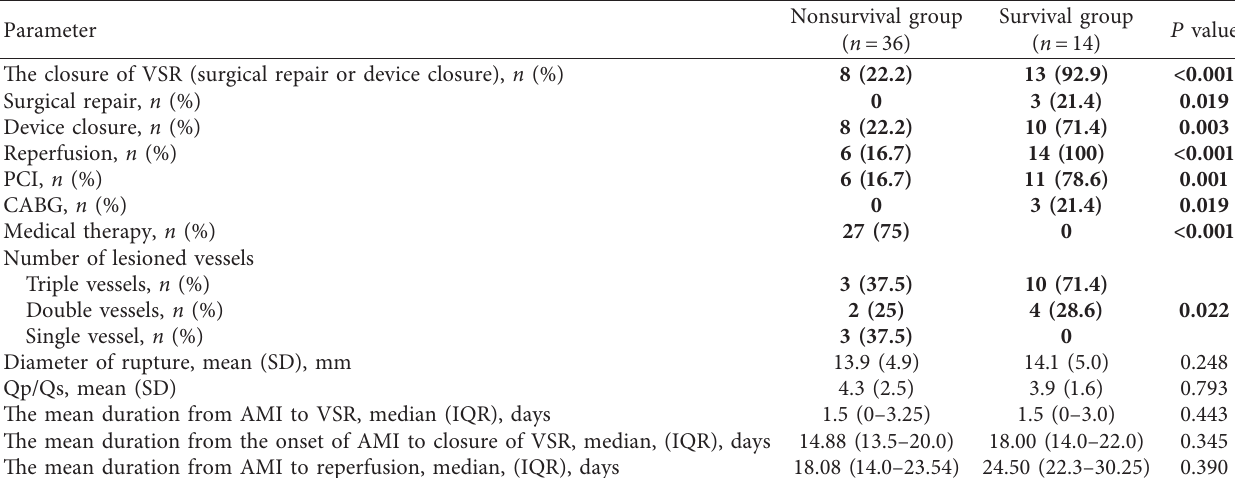
Table 2: Procedural characteristics of patients with ventricular septal